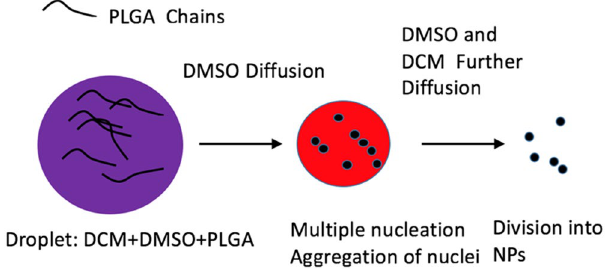
Figure 5. Mechanism of PLGA NPs formation from droplets. Purple color in the left circle represents the mixture of DCM + DMSO; Red color in the middle circle represents the mixture of DCM + DMSO, yet more DCM content; Solid black dots on the right side stand for PLGA NPs presumably still swollen by DCM, until its complete